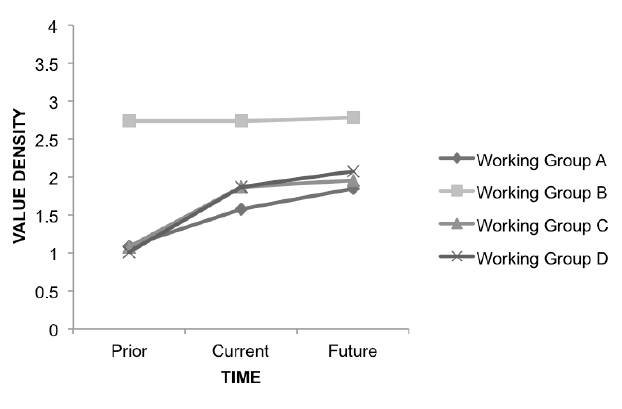
Fig. 2 . Working group density over time.